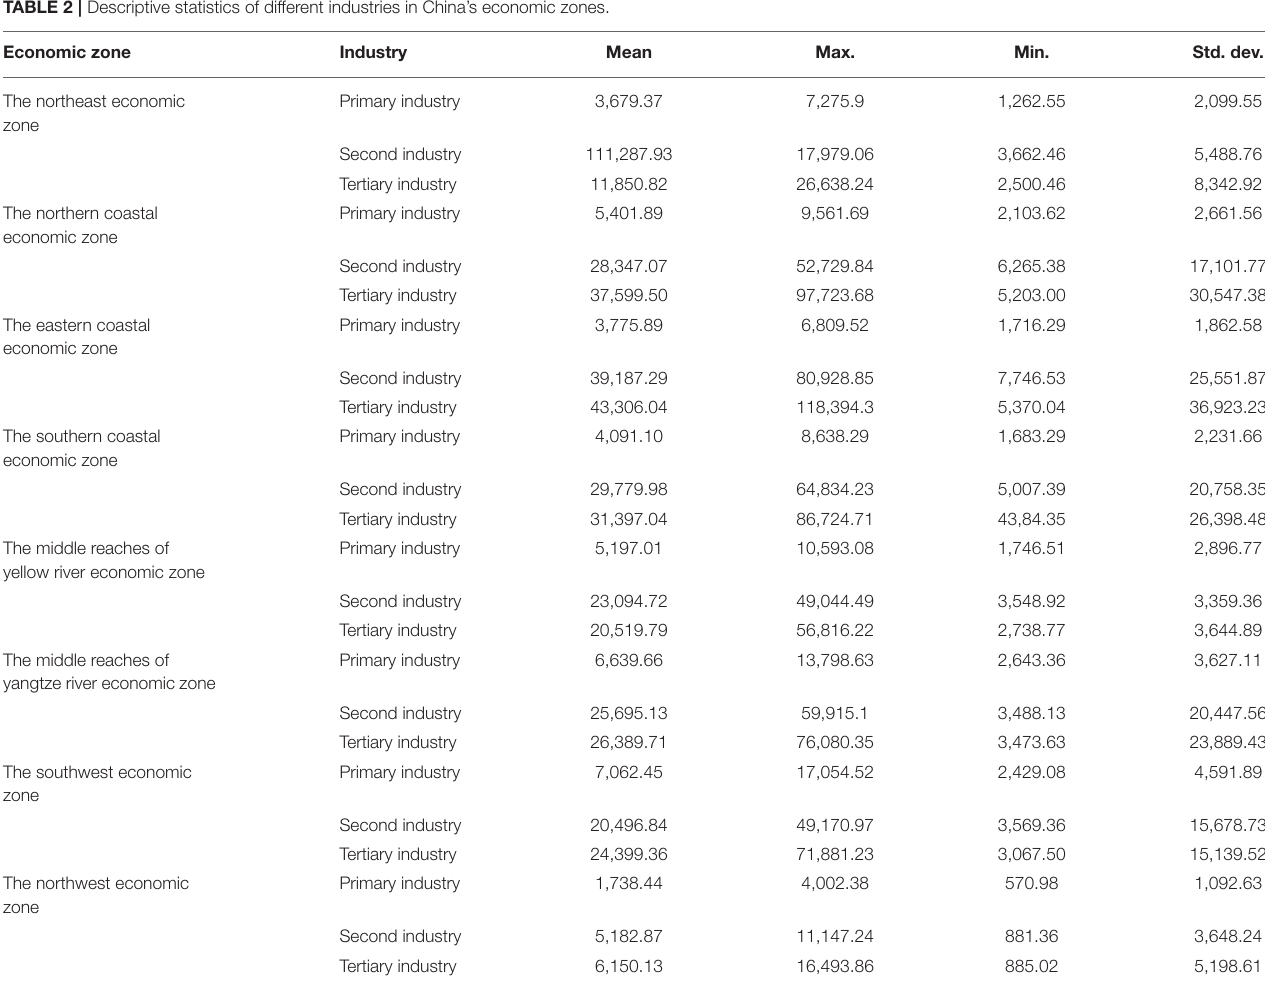
TABLE 2 | Descriptive statistics of different industries in China’s economic